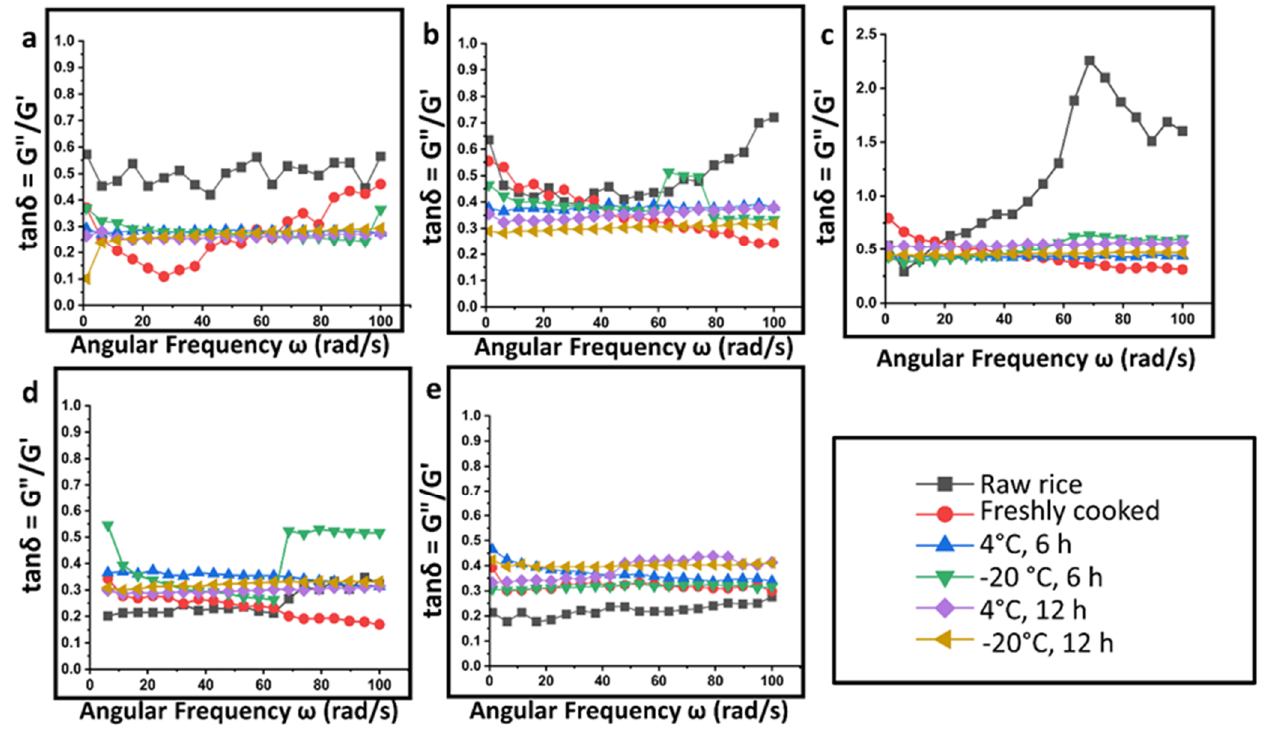
Figure 7. Loss tangent (tan δ = G”/G’) as a function of the angular frequency of rice samples subjected to different storage conditions for retrogradation: ( a ) Diasang lahi, ( b ) Khaju lahi, ( c ) Dhusuri bao, ( d ) Omkar, and ( e ) Bili rajamudi .